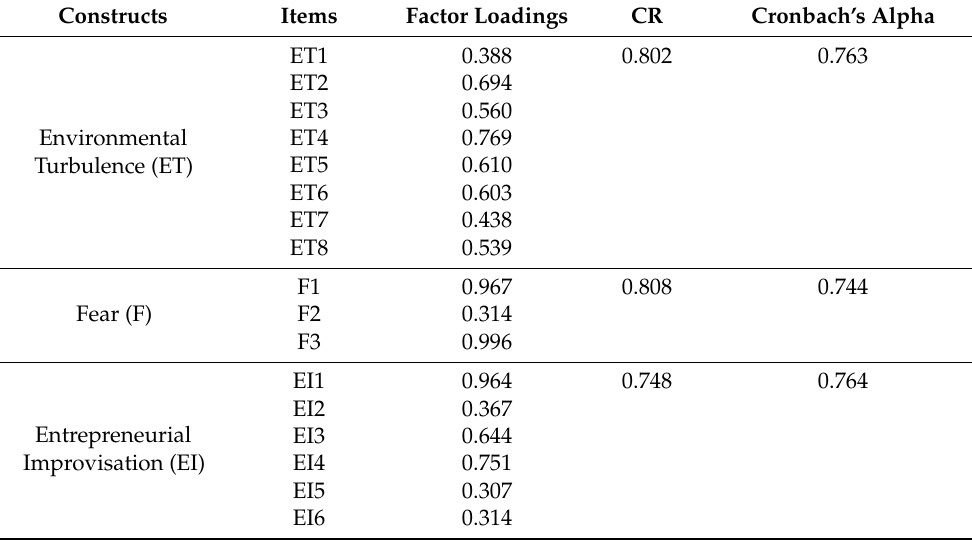
Table 3. Factor loading values ( λ ) of CFA, composite reliability, and Cronbach’s